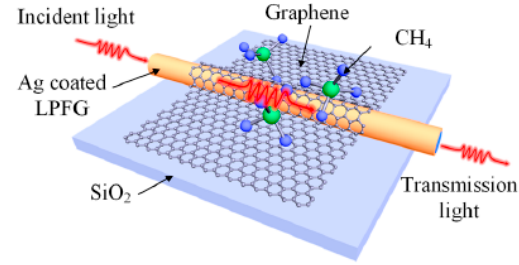
Figure 8. Schematic of the graphene-based LPFG SPR sensor [65].